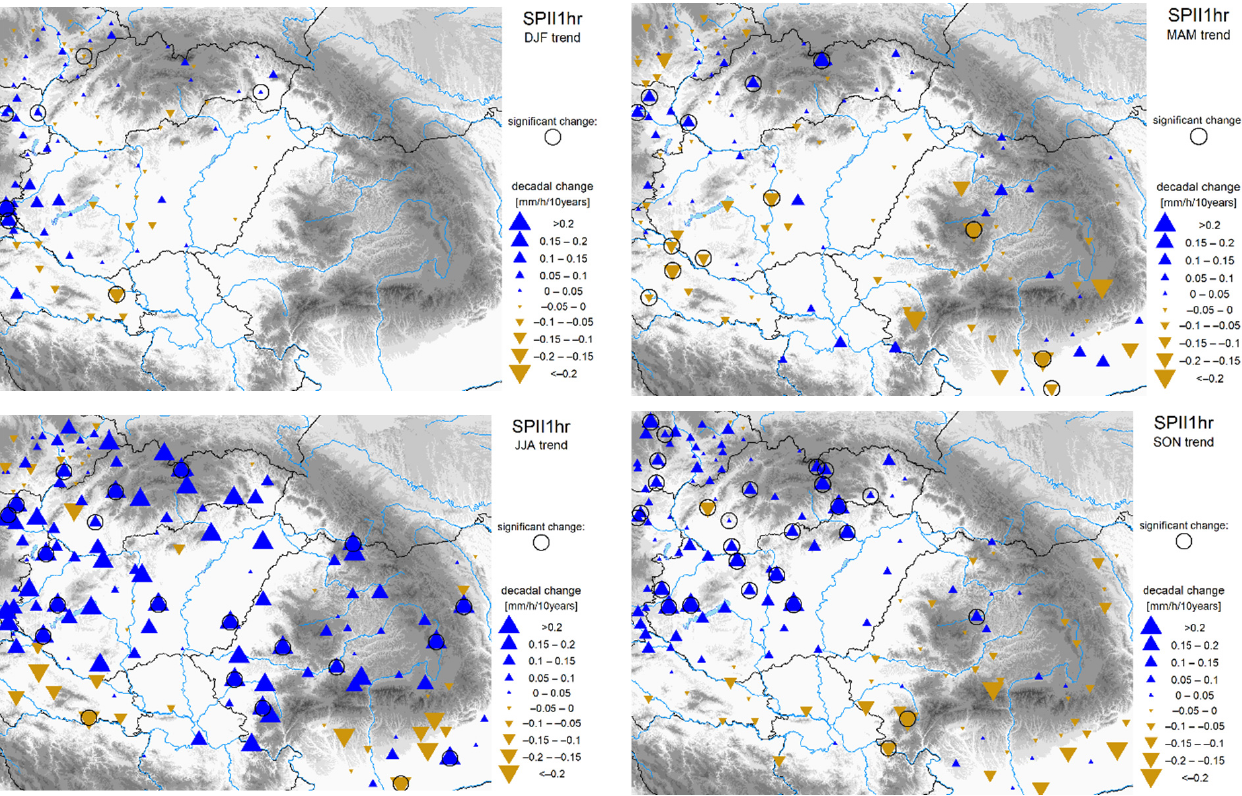
Figure 9. Decadal change of the mean 1-h precipitation intensity (SPII1hr).